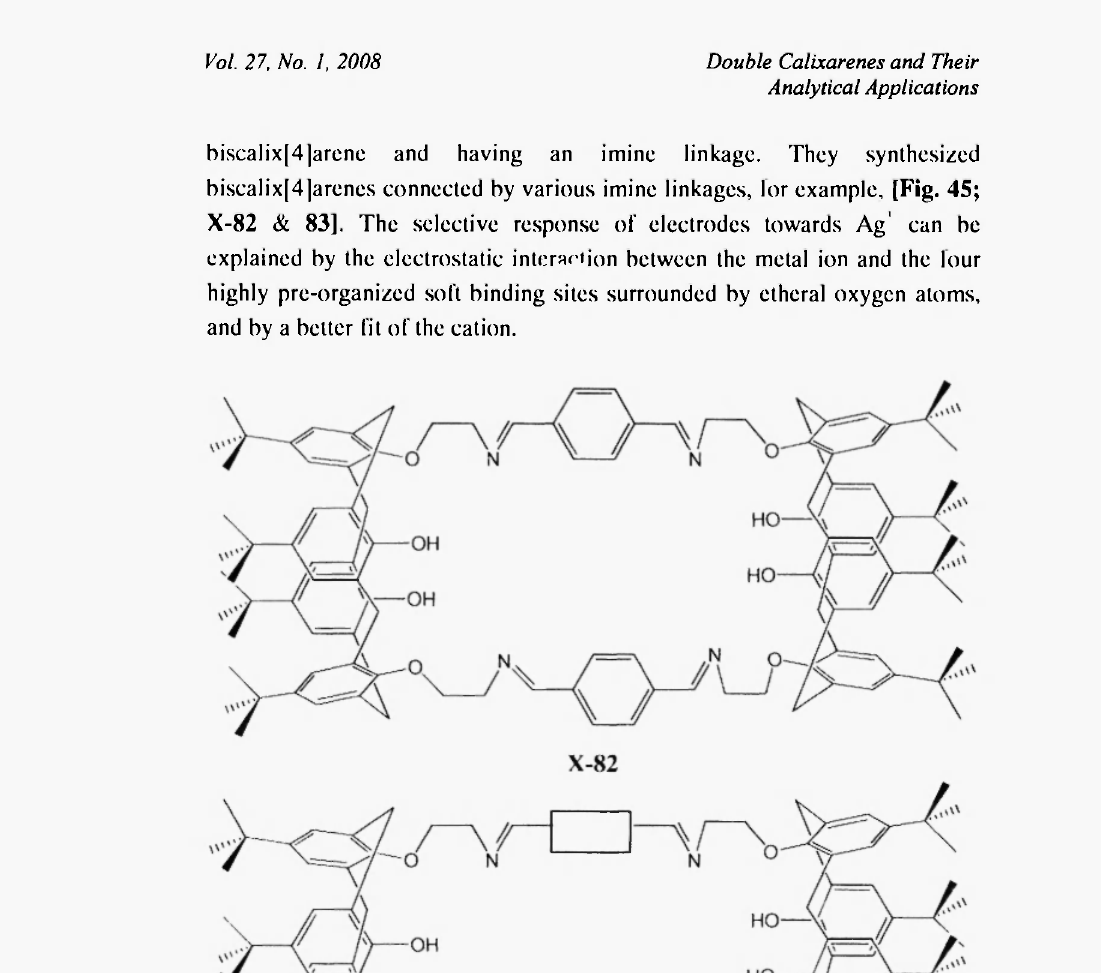
Fig. 45: Mis calix|4|arenes connected via imine